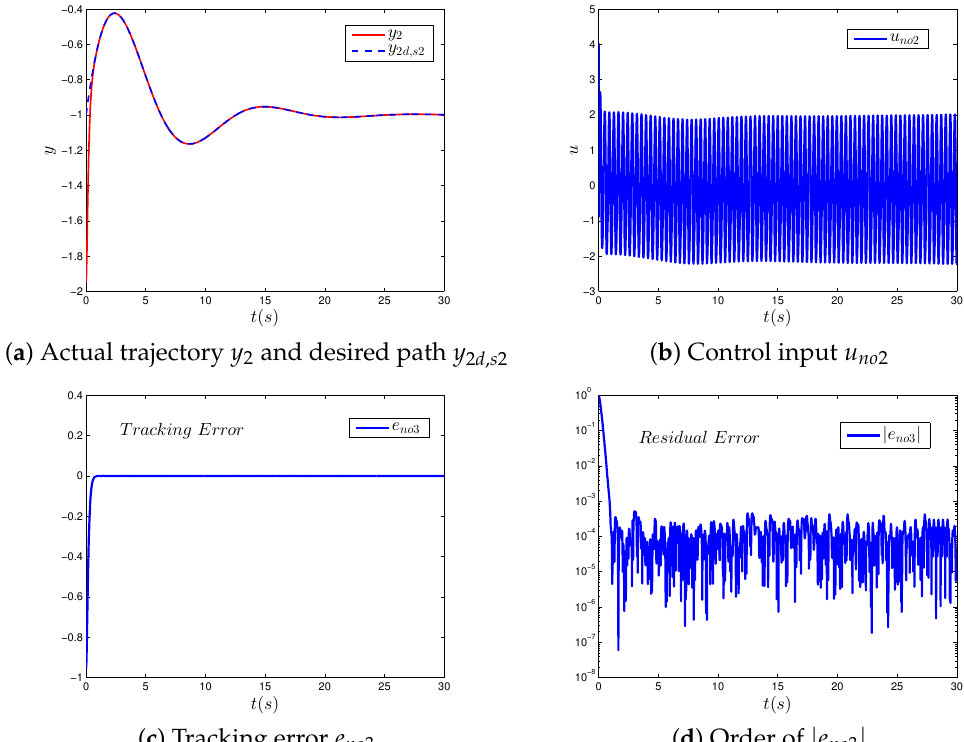
Figure 9. Tracking performance of ZGD controller (26) to solve the tracking control problem with single nonlinear output of the single-link manipulator with flexible joints for the desired path y 2 d , s 2 = sin ( 0.5 t ) exp ( − t /5 )